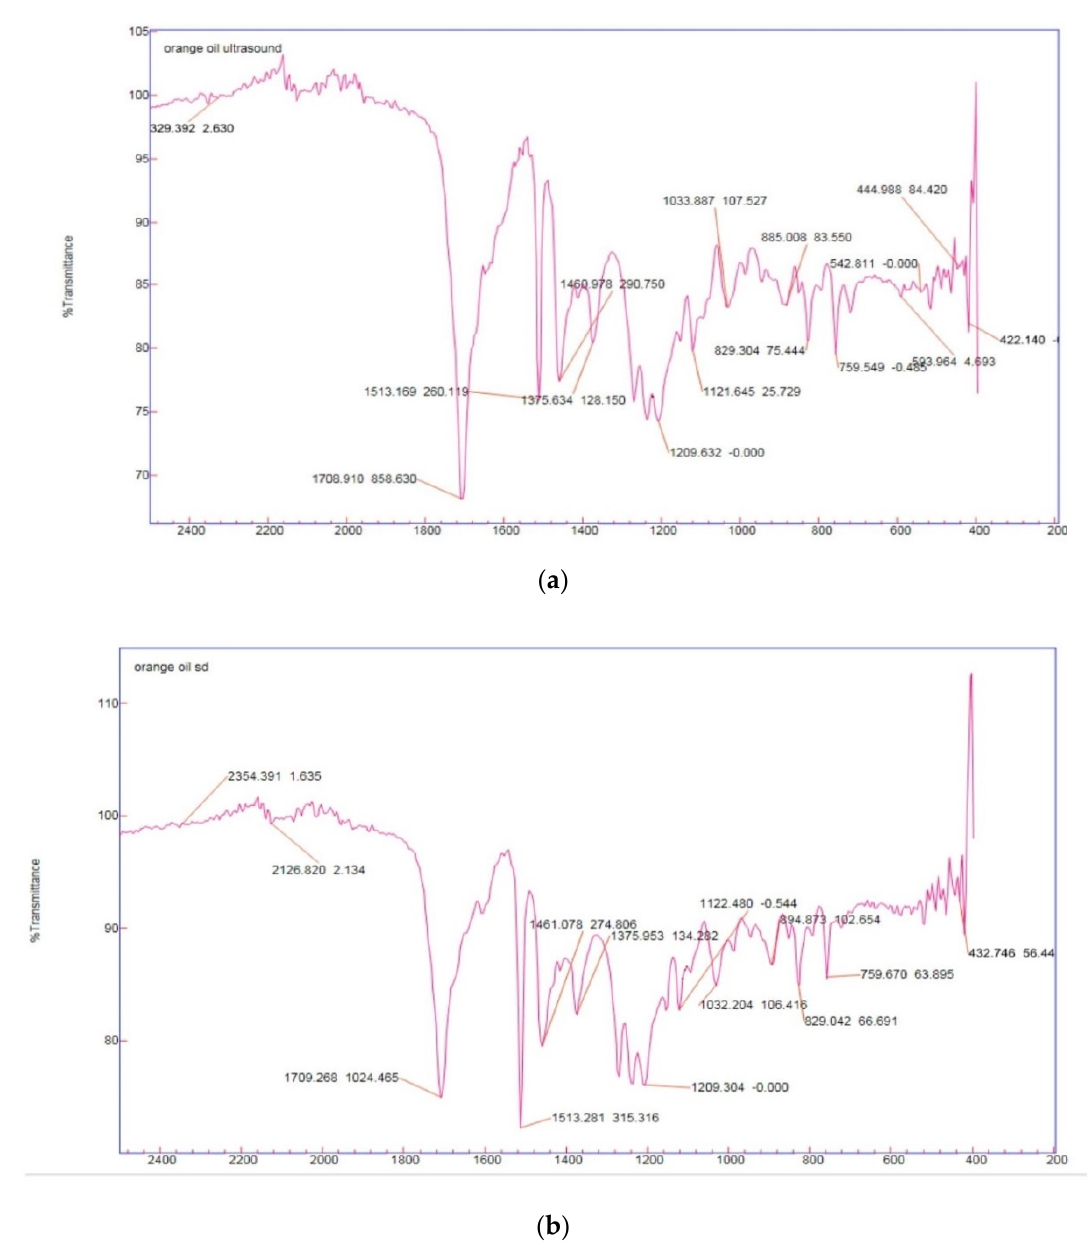
Figure 3. FTIR graph of Ultrasound pretreated sample ( a ) and hydro-distilled sample ( b ). Table 3. GC chromatograph data for hydro-distilled samples and ultrasound pre-treated samples. Peak